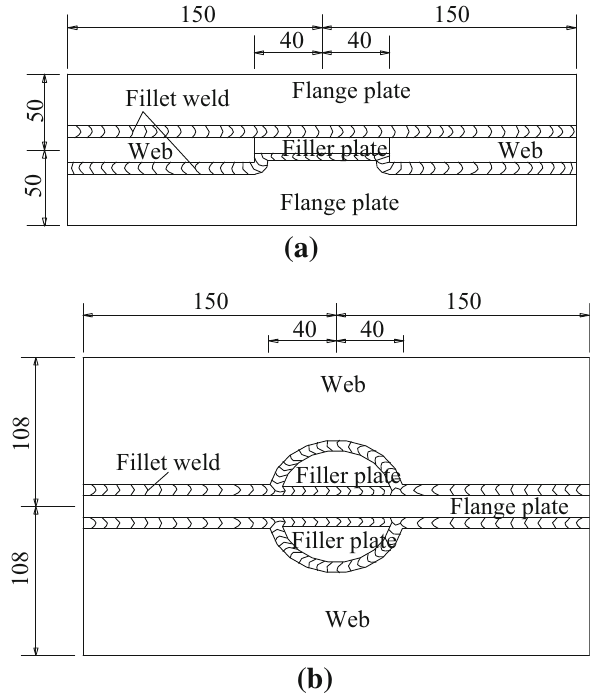
Fig. 1 Geometric dimensions of optimized welded detail (unit: mm). a Flange dimension, b web